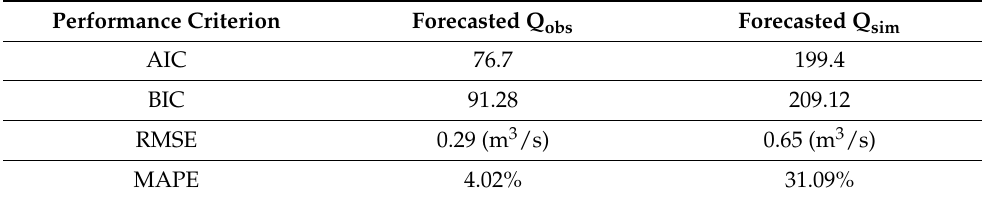
Table 6. Performance of SARIMA model in predicting Lhasa River streamflow from 2017 to 2025 using observed and simulated hydrological time